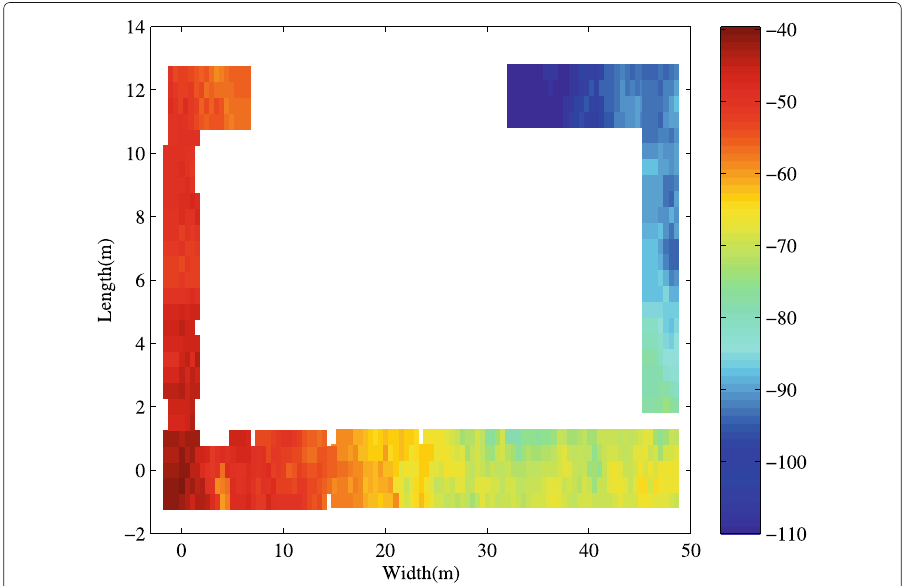
method and step-counter-assisted method. From the Fig. 14, we can draw two conclusions that the error range is very large (from − 35 to 10dB) and the error at each RP fluctuates greatly. If this radio map is used to estimate the user’s location, it will generate a large number of positioning errors.